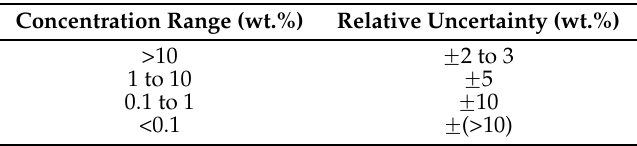
Table 2. Uncertainty in oxide content obtained from ICP-AES.